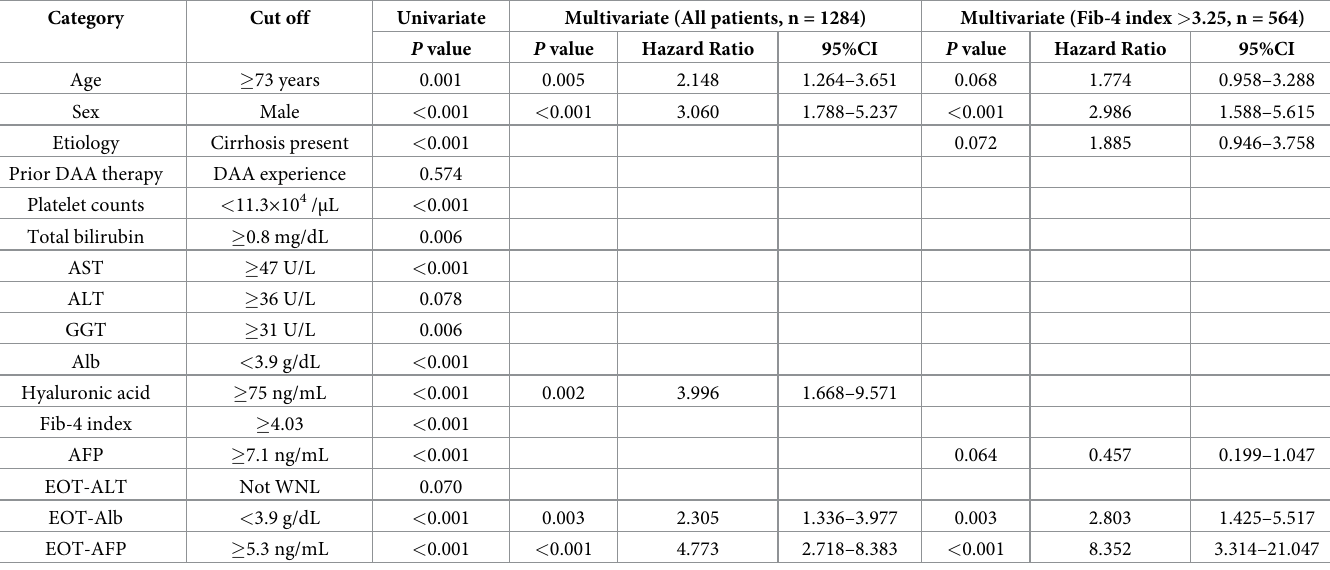
Table 3. Factors associated with the development of hepatocellular carcinoma (HCC) in all patients and severe fibrosis.